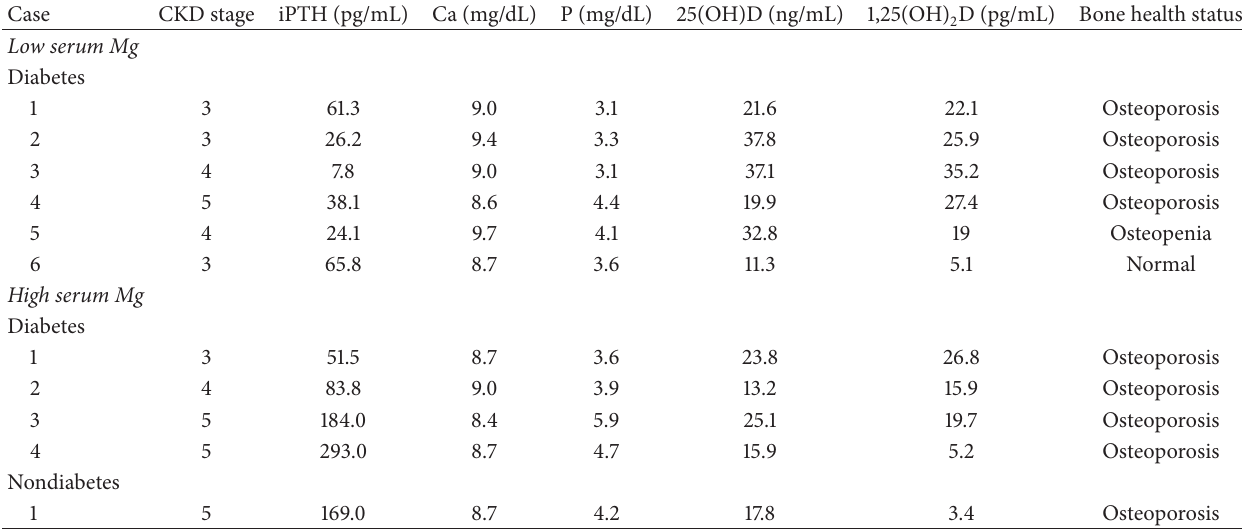
Table 4: Bone metabolic parameters levels for the CKD patients with osteoporosis by low and high serum Mg levels.